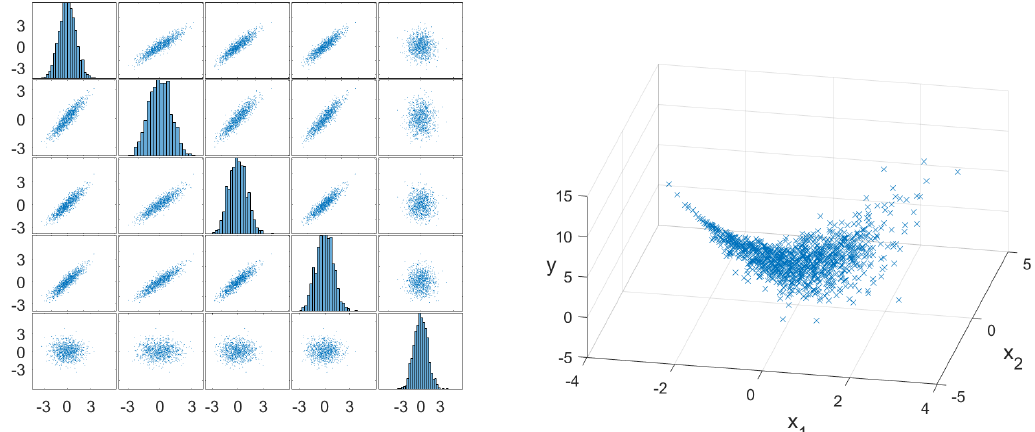
Figure 5. Scatter plots of the predictor matrix 𝐗 , showing bivariate relationships and the distributions of the variables 𝑥 (cid:2869) ,𝑥 (cid:2870) … 𝑥 (cid:2873) on the diagonal from top left to bottom right (left) and 3D scatter plot of the simulated data set, 𝑦 = 𝑥 (cid:2872)(cid:2870) + 𝑥 (cid:2872) 𝑥 (cid:2873) (right).